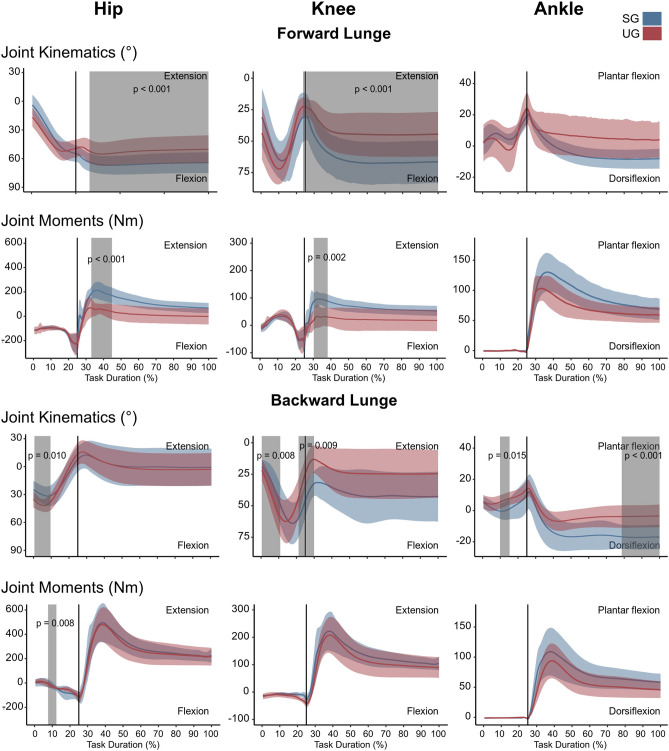
Lower limb kinematics and resultant joint moments of the forward and backward lunges from lift-off until steady state. Each panel shows the mean values and standard deviation bands for the hip, knee and ankle joint angles and moments for the stable (SG—blue) and unstable ground (UG—red) condition. Panels are presented in a time normalized base, vertical lines represent touchdown. Gray bands denote periods of significant differences assessed with a statistical parametrical mapping difference estimator Bonferroni corrected.